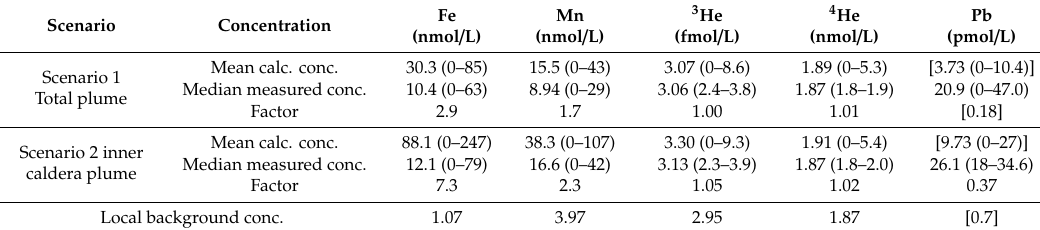
Table 6. Mean calculated and measured concentrations of dissolved Fe, Mn, Pb, 3 He, and 4 He of two hydrothermal plume scenarios at Brothers volcano with propagated uncertainty, which is indicated by the range given in round parentheses. The median of measured concentrations is given with 1s standard deviation of representative plume samples (range presented in round parentheses). For Fe and Mn, we used the flux (J SHD ) based on concentrations in the plume (Niskin bottles) for a comparison with average measured data and for 3 He and 4 He the fluxes based on end-member concentrations were used. Local background concentrations were already added to the respective mean calculated concentration to enable a comparison. Background concentrations are measured concentrations between 1000 and 1700 m depth at the TMR background station of the cruise SO 253 ( − 35.25837 ◦ S, 178.7771 ◦ E). Scenario